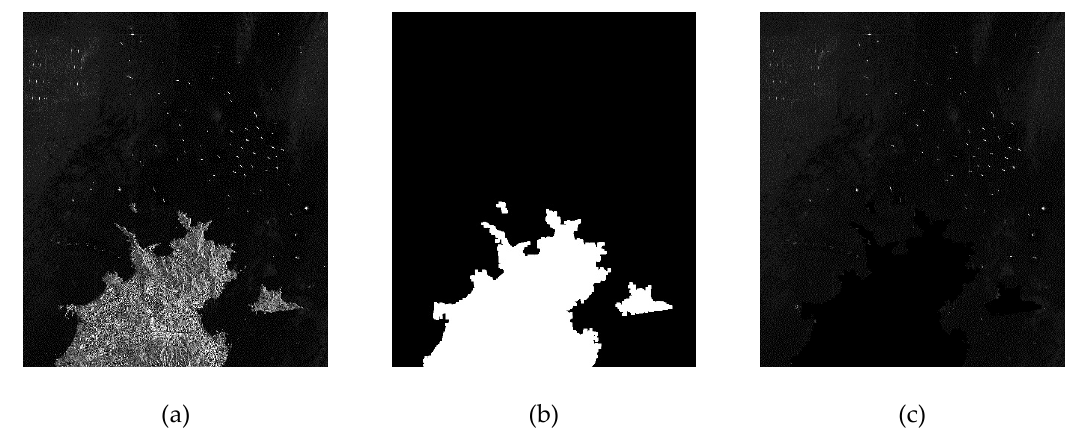
Figure 7. Sea-land segmentation results of a large-scale GF-3 image. ( a ) The original image; ( b ) The land mask; and ( c ) The image after land masking. Table 7. Compositions of the large-scale SAR